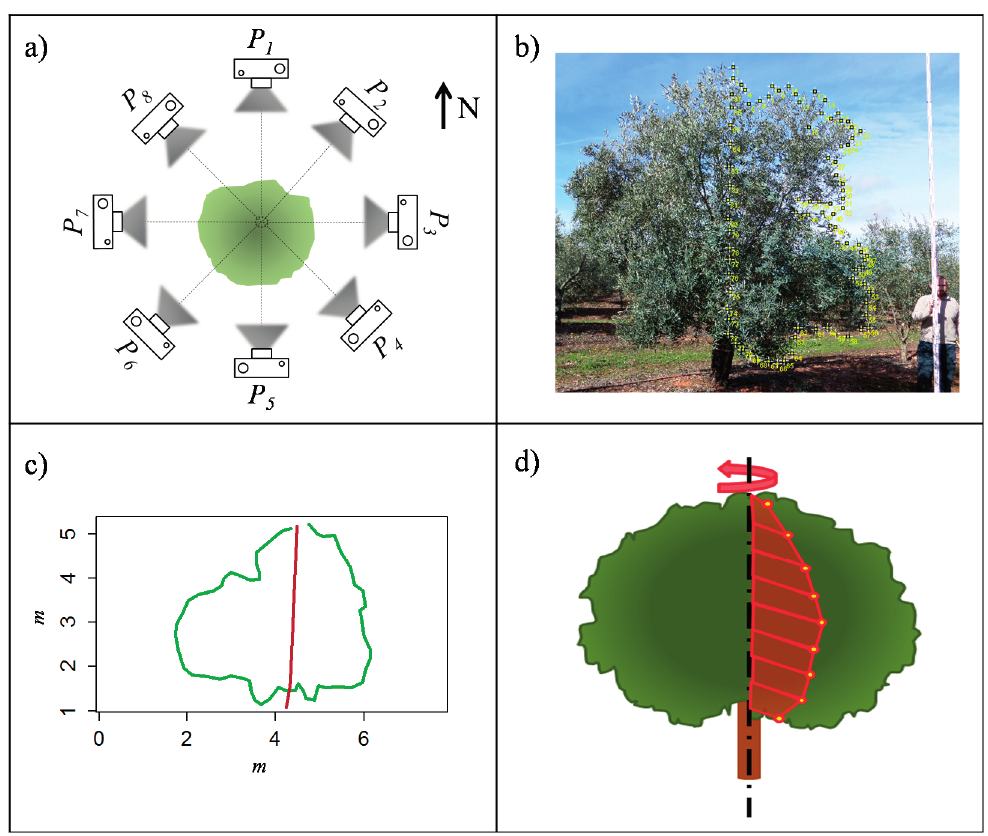
Figure 4. Procedure to characterise tree silhouette from each picture (P i ) that was taken from all sides (every 45°) of the tree: ( a ) 8 Picture positions; ( b ) Manual contour delimitation; ( c ) Surface automatic calculation; and ( d ) Surface